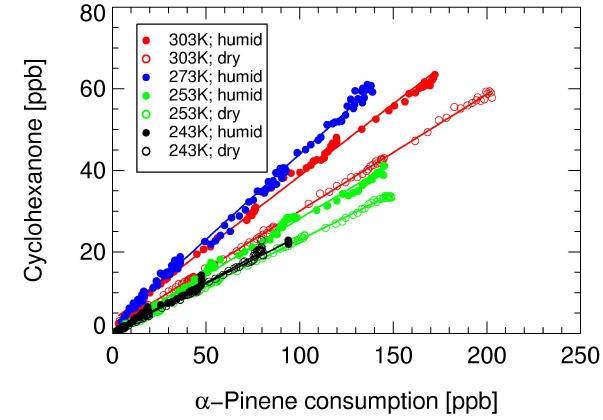
Fig. 9. Mixing ratio of cyclohexanone vs. the α -pinene consump- tion. The slopes of the straight lines are proportional to the OH yield of the α -pinene+ozone